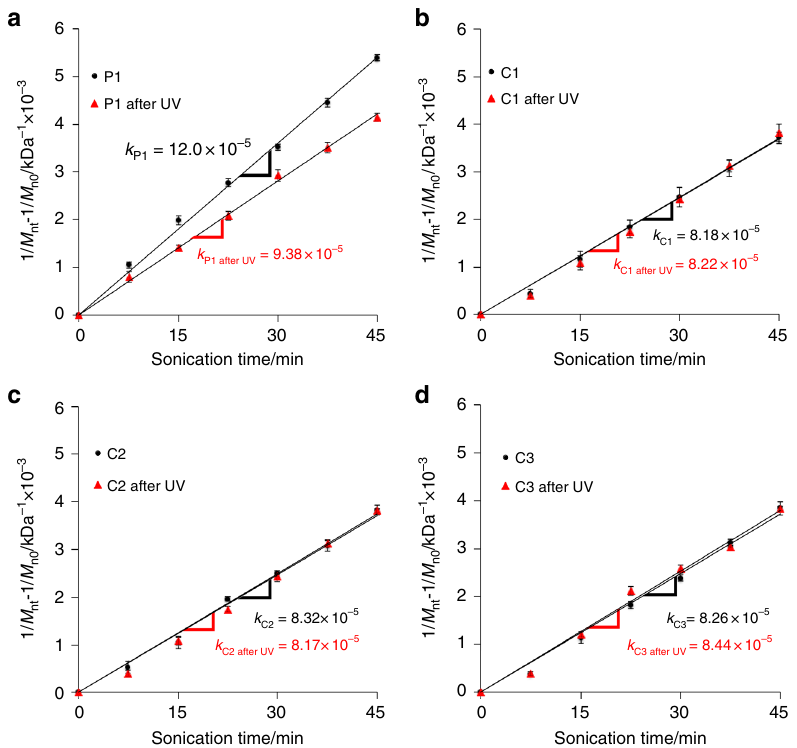
Fig. 5 Rate of polymer chain scission upon exposure to pulsed ultrasound. a – d Cleavage rate of P1 , C1 , C2 , and C3 before and after irradiation with UV light (313 nm, 1 h). A 2 mg mL – 1 polymer solution was sonicated with pulsed ultrasound (10.6 W cm – 2 ) under an atmosphere of argon in an ice water bath. Measurements were performed in triplicate, and the error bars represent a standard